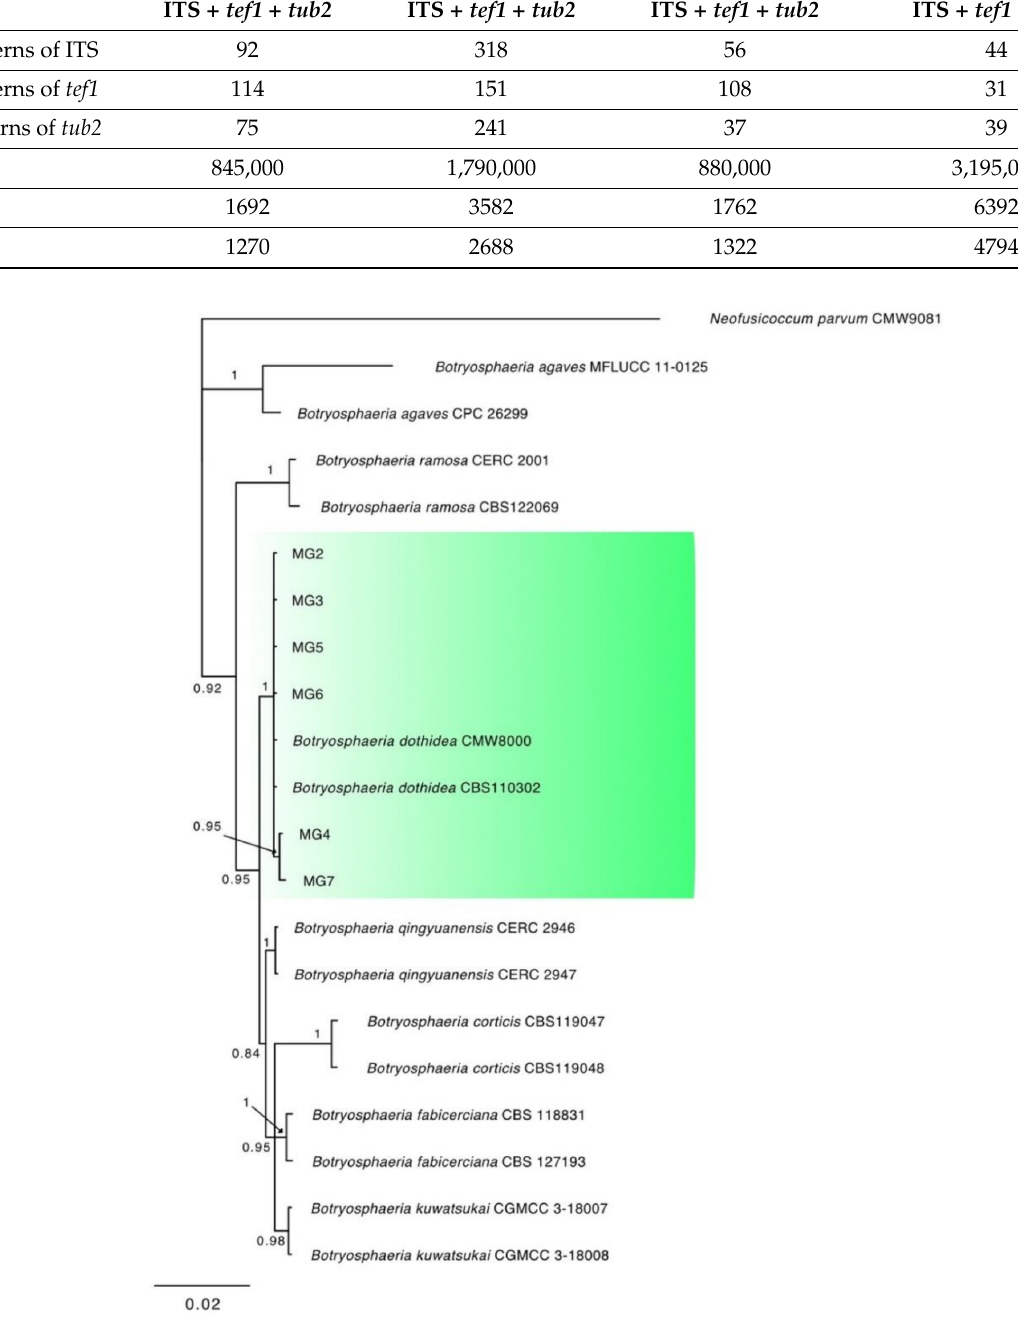
Figure 3. Consensus phylogram of 1692 trees resulting from a Bayesian analysis of the combined ITS, tef1 , and tub2 sequence of Botryosphaeria species. The tree was rooted to Neofusicoccum parvum (CMW9081). Bayesian posterior probability values are indicated at the nodes. The cluster containing the isolates obtained in this study is highlighted in